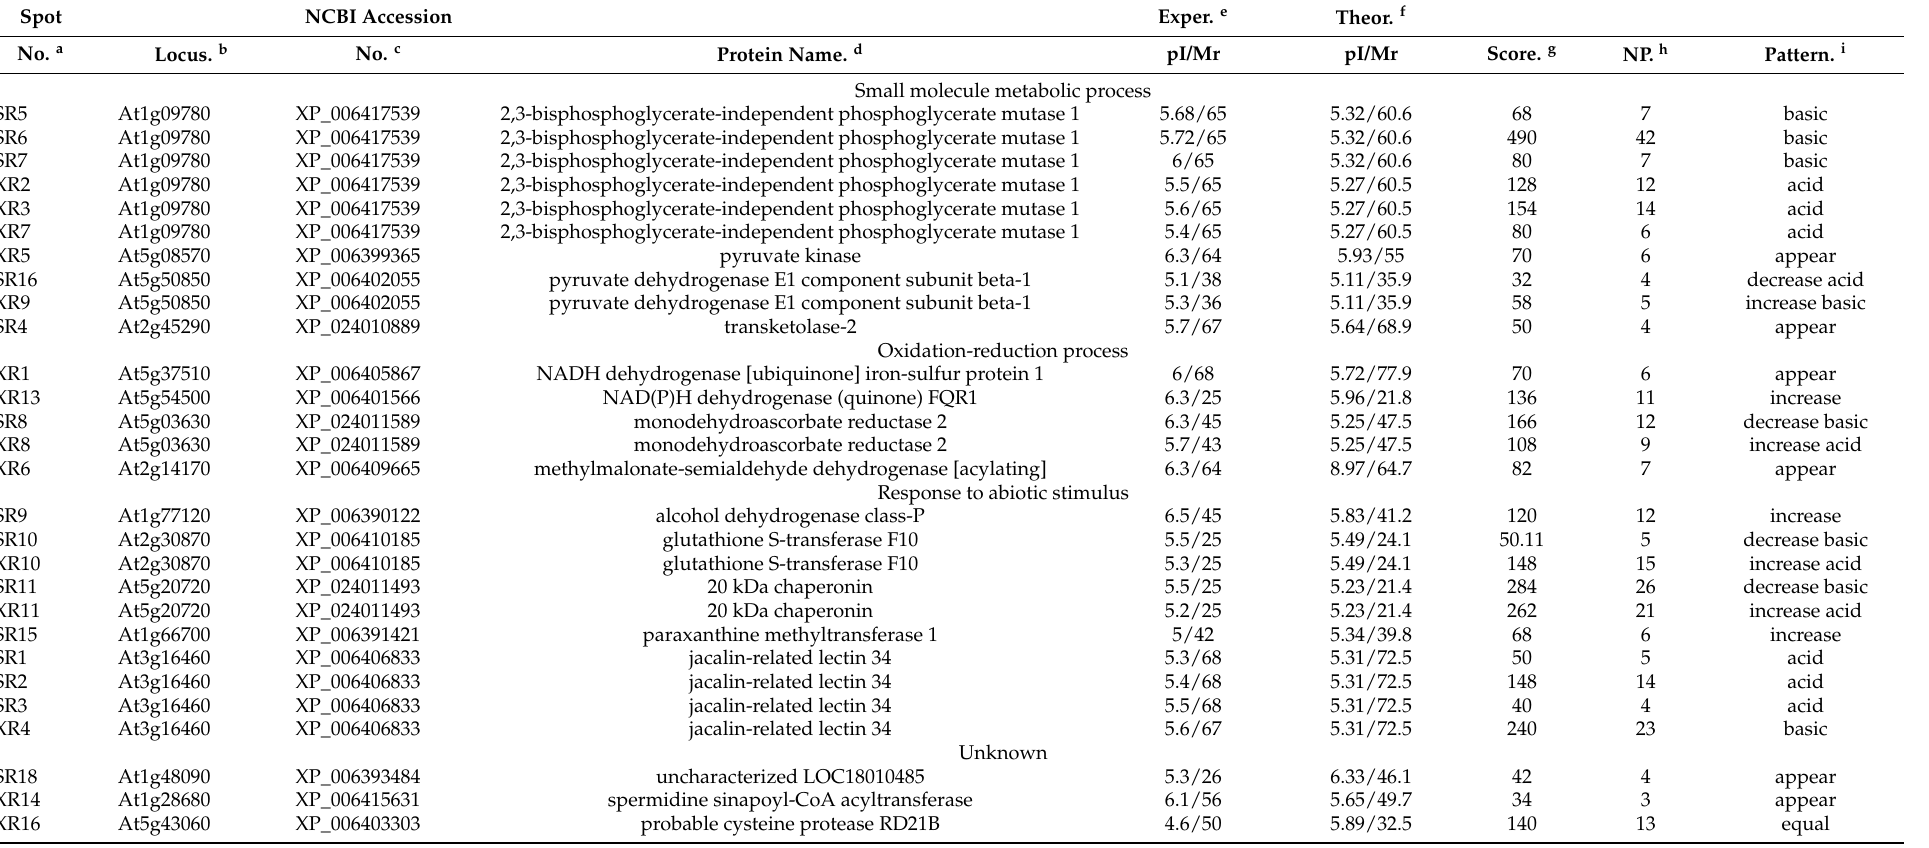
Table 2. Differentially expressed proteins identified in roots of SD and XJ ecotype of Eutrema